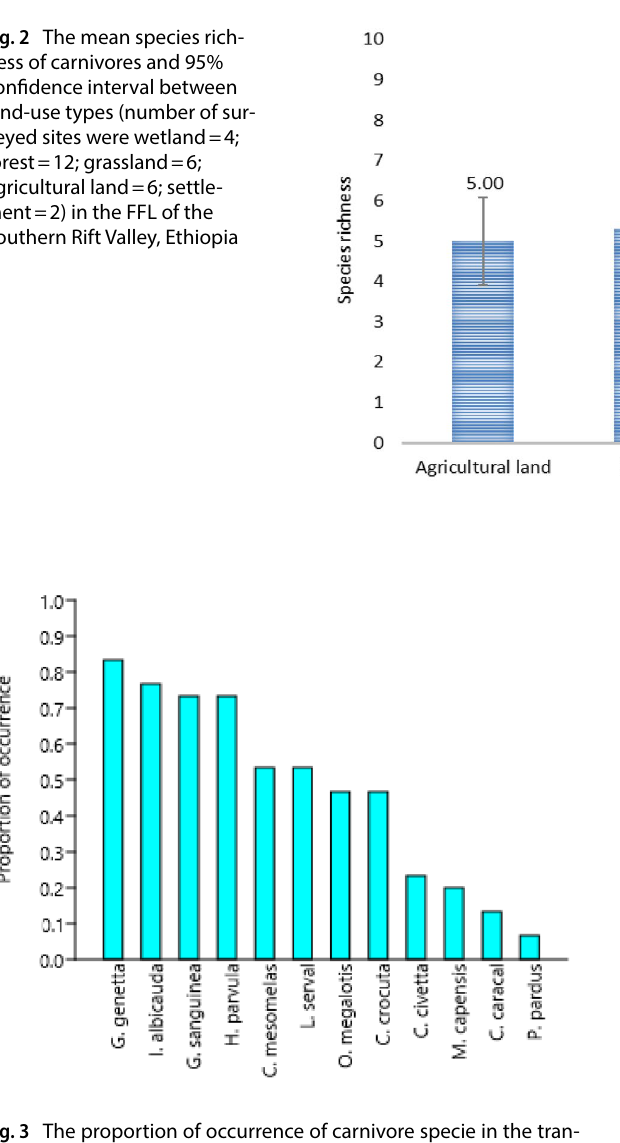
Fig. 3 The proportion of occurrence of carnivore specie in the tran- sects based on presence-absence data in the Faragosa-Fura Land- scape of Southern Rift valley, Ethiopia. The proportion of occur- rence calculated as the number of sites where species occurred divided by 30 total surveyed sites